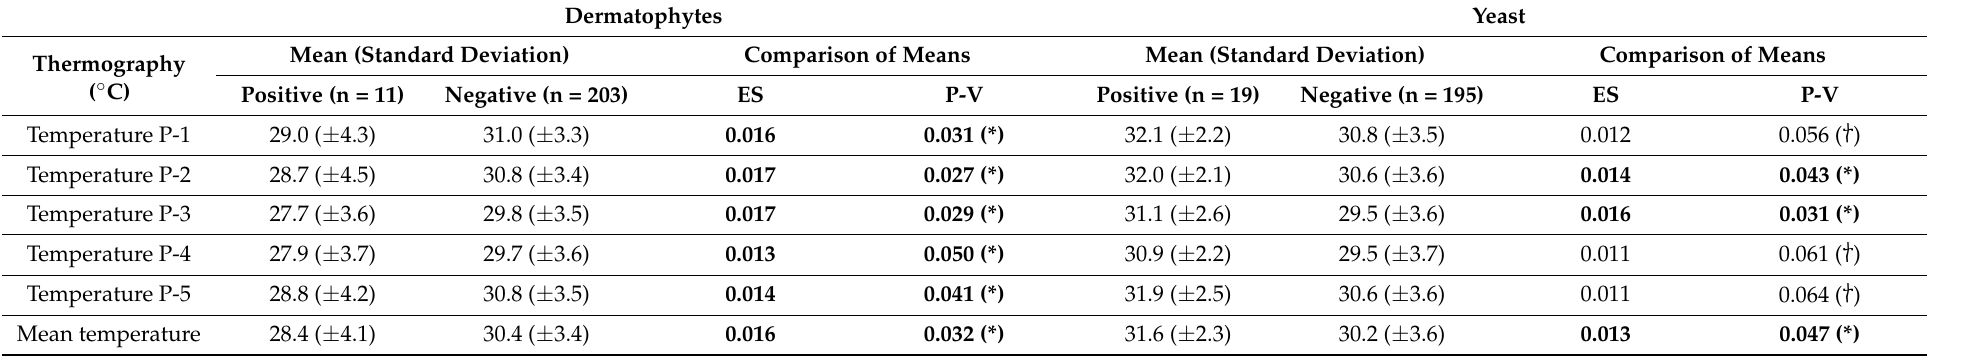
Table 6. Relation of results of thermography variables and prevalence of dermatophyte and yeast infection.